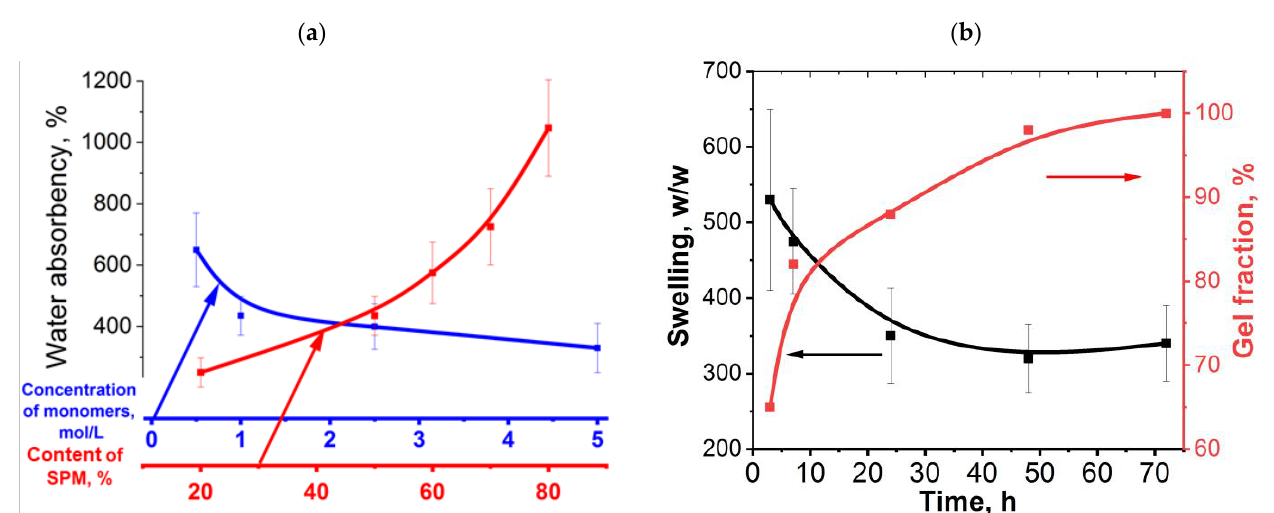
Figure 2. Dependences of the water absorbency/swelling degree of cryogels in distilled water on the total concentration of monomers (( a ), blue line), on SPM content in the system (( a ), red line), on the reaction time (( b ), black line) and dependence of the content of the gel fraction in the system vs. the reaction time (( b ), red line). The arrows indicate the corresponding dependences shown in color.